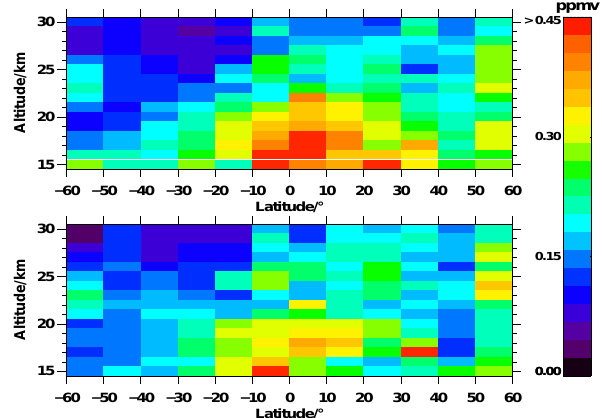
Figure 8. “Quasi-amplitudes” of fitted terms representing the solar cycle in the regression, i.e. the halved differences between the max- ima and minima along the time series of these contributions. Top panel: harmonic parametrization; lower panel: F10.7 parametriza-